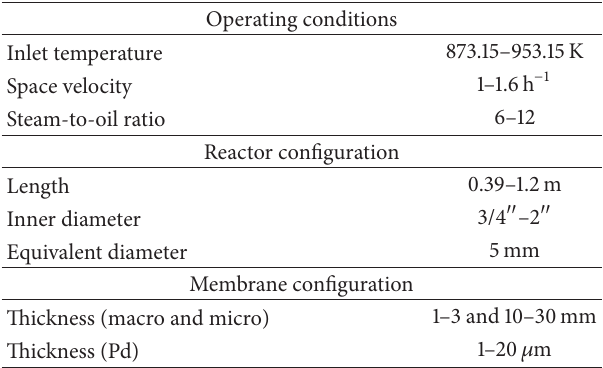
Table 1: Ranges of variation of the operating conditions and system configuration.